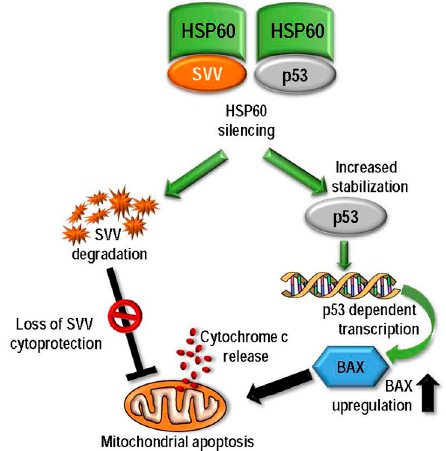
Figure 5. Mechanisms of HSP60 mediated cytoprotection. HSP60 regulates apoptosis via two mechanisms–modulation of mitochondrial survivin (SVV) stability and control of p53 expression. HSP60 is an SVV associated protein as it complexes with survivin in the mitochondria to stabilize SVV. Moreover, HSP60 also forms a complex with p53, which decreases the stability of p53, thus inhibiting the pro-apoptotic functions of p53 in cancer cells. Silencing of HSP60 leads to loss of chaperonage function leading to the loss of SVV which results in activation of the mitochondrial apoptotic pathway. In addition, HSP60 silencing leads to enhanced stabilization of p53 proteins leading to p53-dependent transcription of apoptotic factors like BAX that ultimately promote cell death (based on Ghosh et al., [74]).